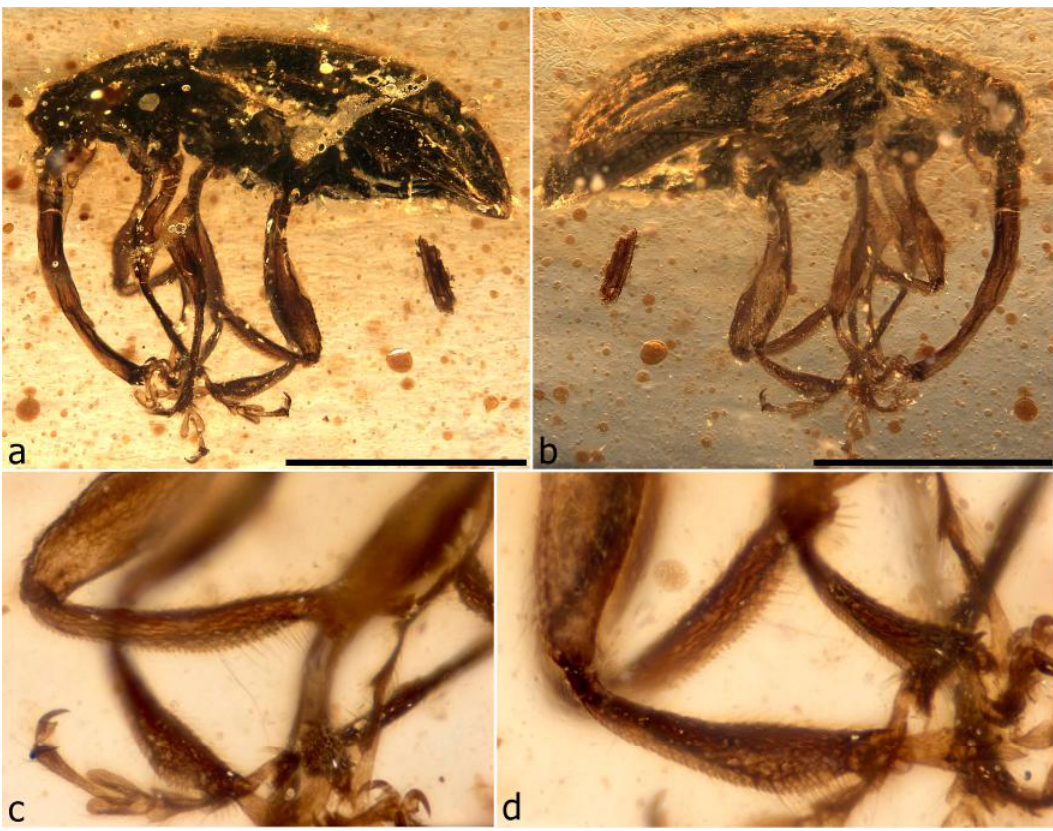
Figure 85. Bowangius sp. 3. Habitus, left lateral ( a ); habitus, right lateral ( b ); legs ( c ); legs, showing detail of metatibial serrulation ( d ). Scale bars: 1.0 mm